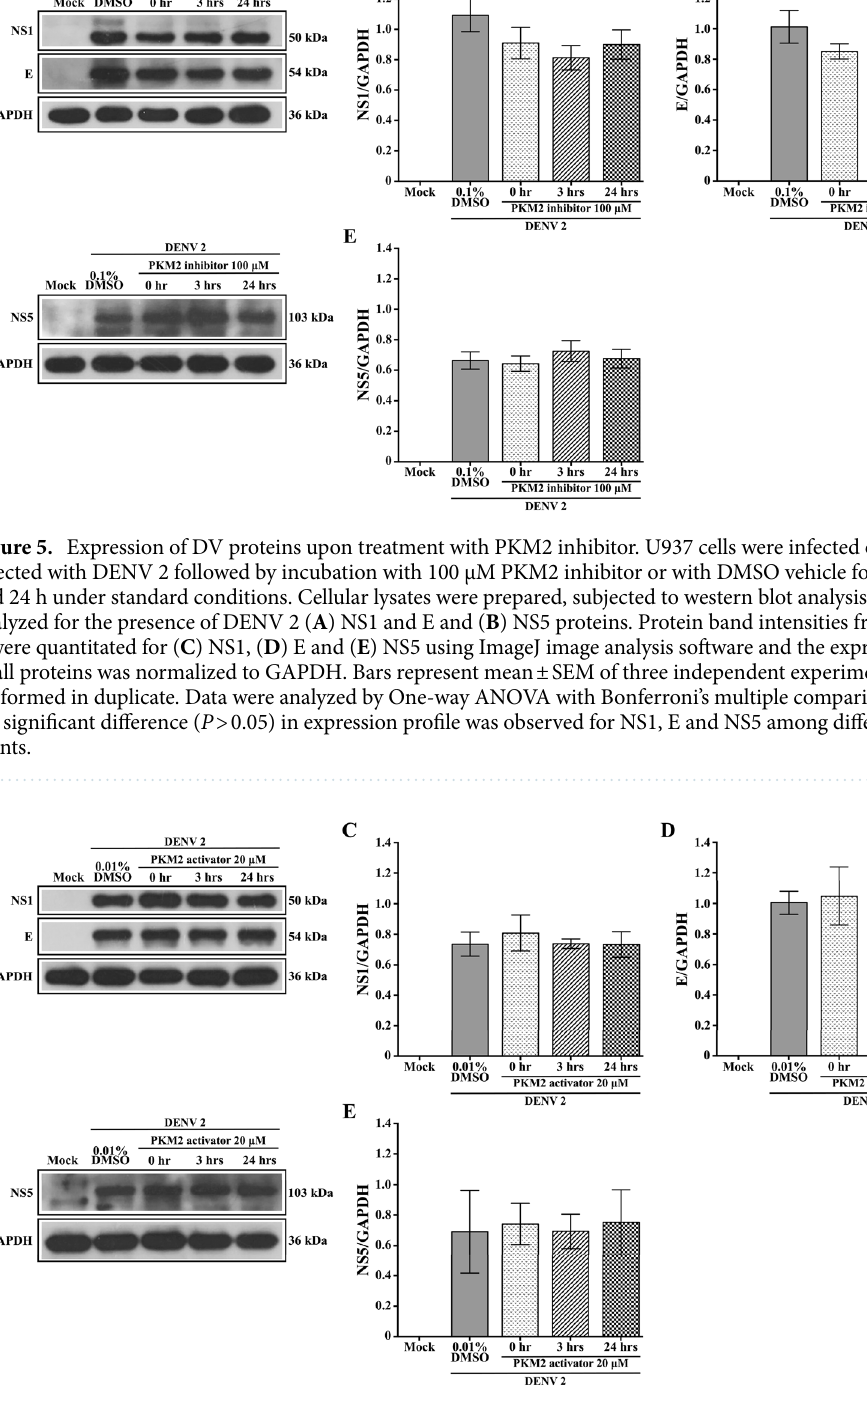
Figure 6. Expression of DV proteins upon treatment with PKM2 activator U937 cells were infected or mock infected with DENV 2 followed by incubation with 20 μM PKM2 activator or with DMSO vehicle for 0, 3 and 24 h under standard conditions. Cellular lysates were prepared, subjected to western blot analysis and analyzed for the presence of DENV 2 ( A ) NS1 and E and ( B ) NS5 proteins. Protein band intensities from A and B were quantitated for ( C ) NS1, ( D ) E and ( E ) NS5 using ImageJ image analysis software and the expression all proteins was normalized to GAPDH. Error bars represent mean +/- SEM of at least three independent experiments performed in duplicate. Data were analyzed by One-way ANOVA with Bonferroni’s multiple comparison test. No significant difference ( P > 0.05) in expression profile was observed in NS1, E and NS5 among different time